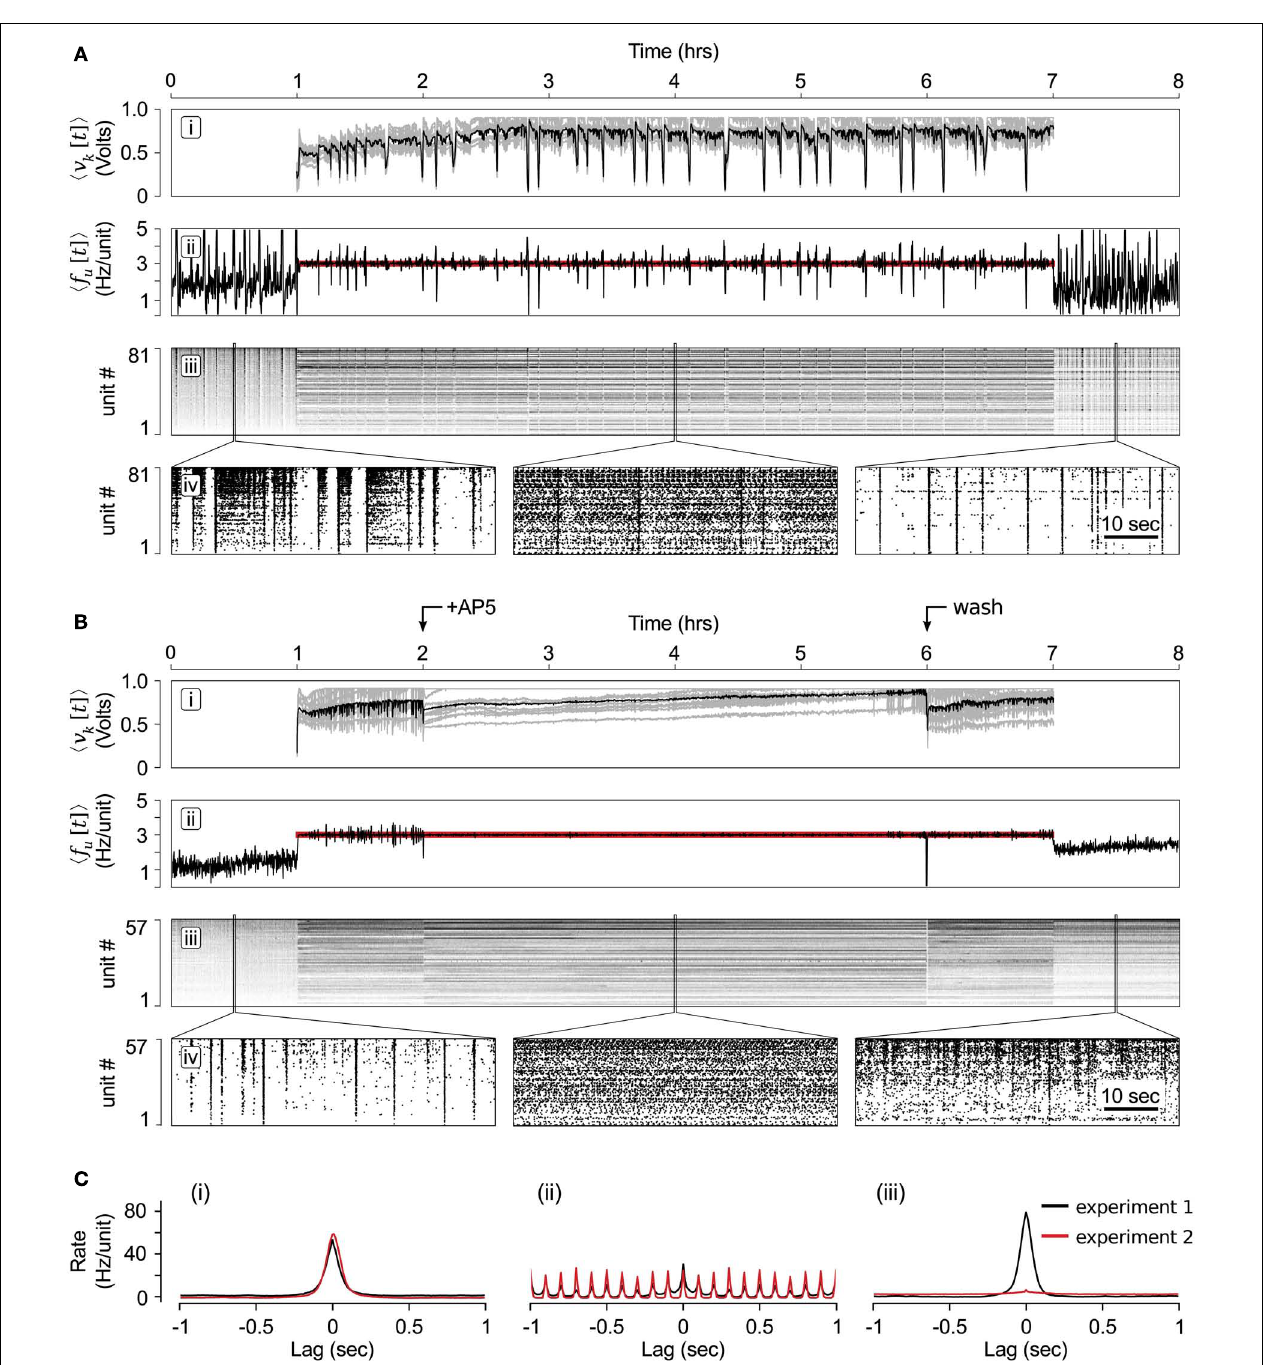
Average pair-wise correlation functions between units for experiments with and without AP5 application (red and black lines, respectively). Cross-correlations were created from spiking data (i) during spontaneous activity before the closed-loop controller was engaged, (ii) half-way through the closed-loop-control period, and (iii) during spontaneous network activity following closed-loop control.The data used to create the correlation functions is centered about locations used to create the rastergrams shown in (A iv ) and (B iv ) .To create the correlation functions, unit firing rates were calculated using 10ms time